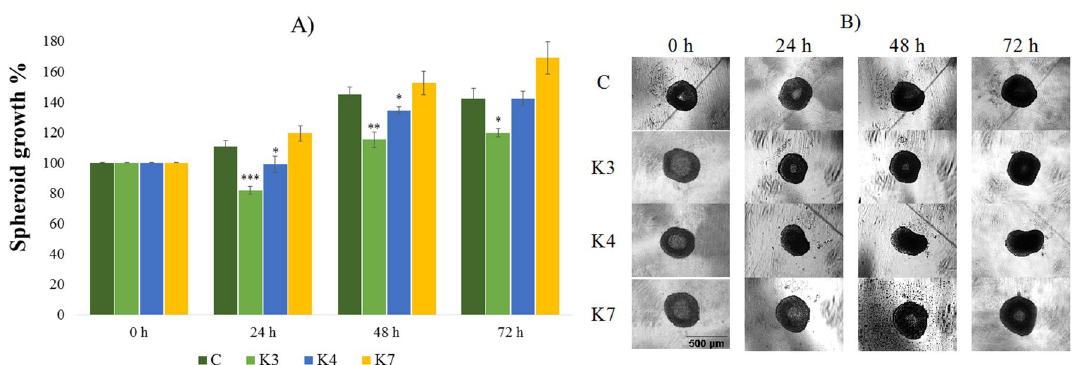
Figure 5. The impact of K3 , K4 , and K7 (1 µM) on sensitive MCF-7 spheroids formation after 24, 48, and 72 h exposure ( A ). Representative images of sensitive MCF-7 spheroids at 0–72 h of experiment ( B ), scale bar = 500 µm. The control spheroids ( C ) were treated with 1% V/V DMSO. After incubation, the spheroid areas were determined and the spheroid growth was calculated ( A , relative to control). Data are expressed as the average of spheroid growth (%) of nine repetitions with the corresponding standard error of the mean. The statistical differences between the control spheroids and treated spheroids were calculated by using a two- compound t-test at the level *p < 0.05, **p < 0.01, ***p <